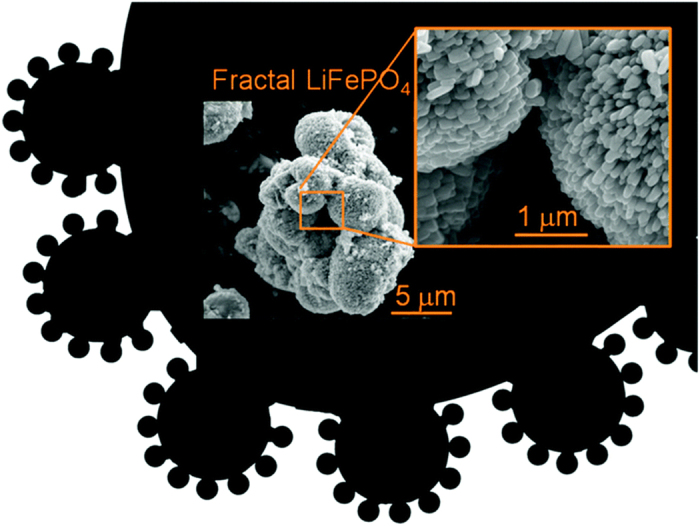
Scheme of LiFePO4 fractal granularity design.